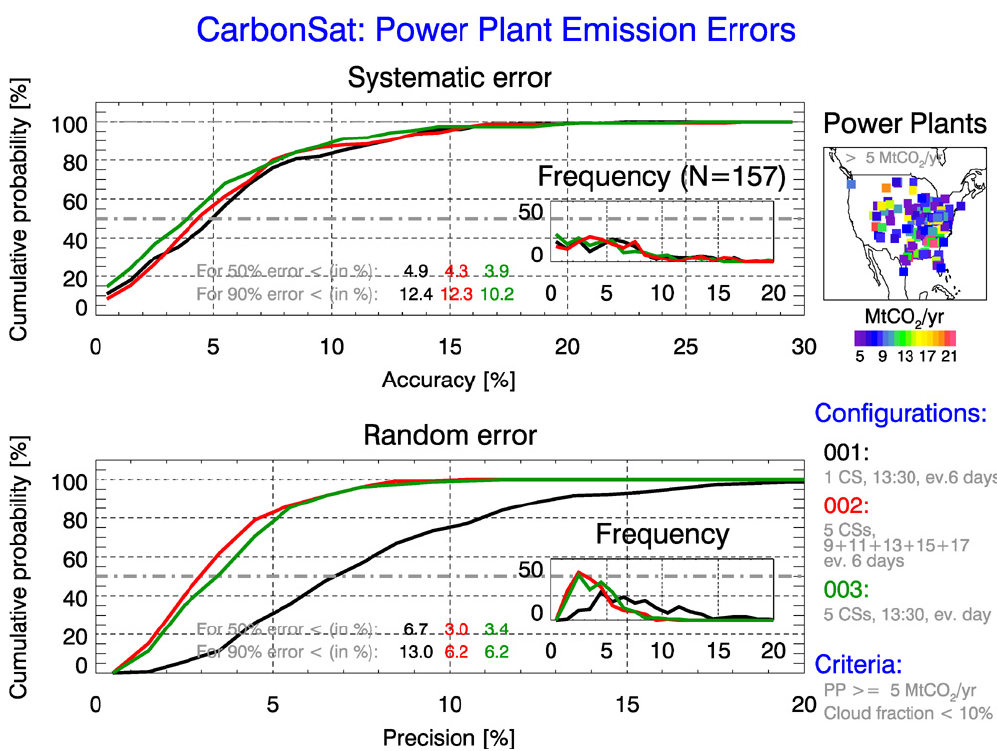
Fig. 10. Error analysis for different CarbonSat configurations, done for power plants with emissions of more than or equal to 5MtCO 2 yr − 1 . The systematic errors for different configurations (color-coded) are shown in the top panel and random errors are shown in the bottom panel.